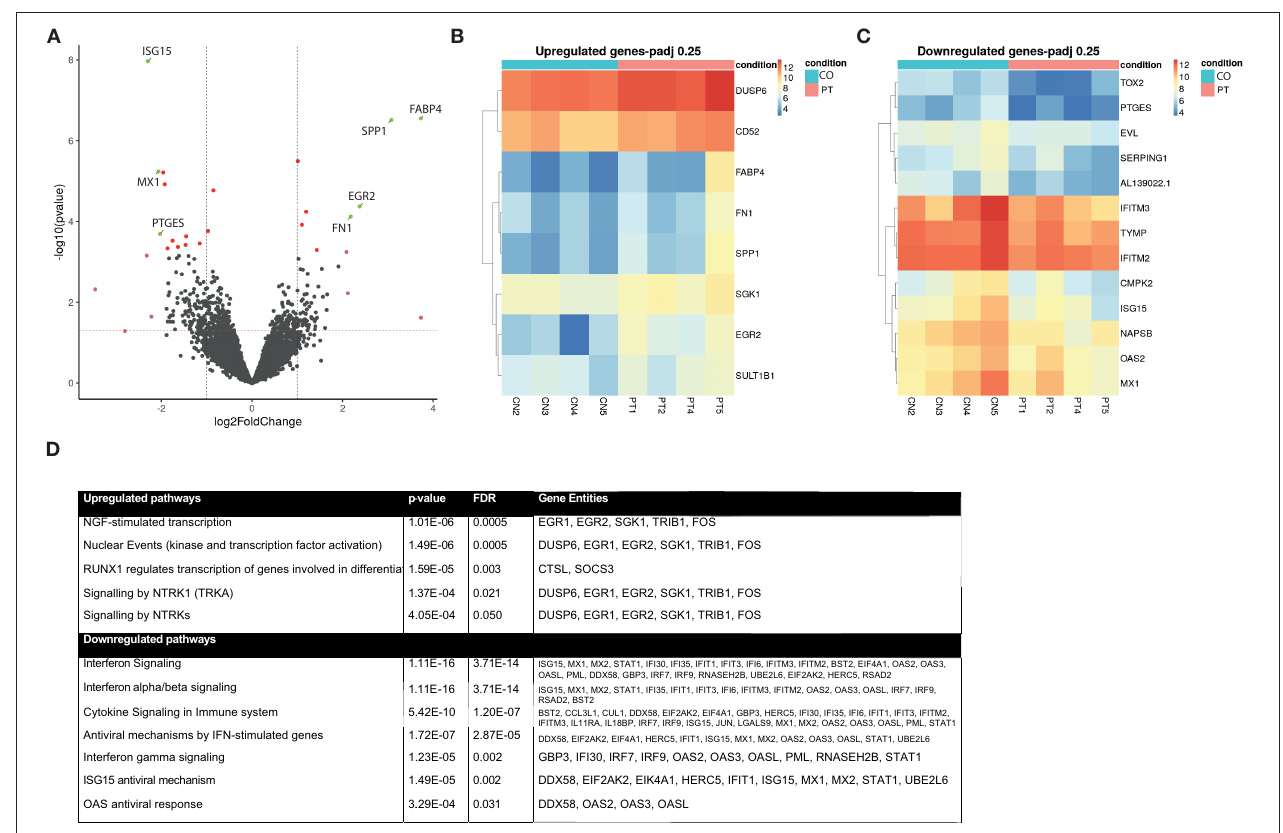
FIGURE 3 | Monocyte transcriptome analysis. Differentially regulated gene expression between participants with SVD progression ( n = 4) and without ( n = 4). (A) Volcano plot of differentially expressed genes after sex stratification. Green dots indicate adjusted P -value < 0.25 and log Fold Change > ± 2; Dark red dots, genes with P -adj < 0.25; light red dots, genes with logFC > ± 2. (B) Heatmap of upregulated genes with P -adj < 0.25 corrected for sex. (C) Heatmap of downregulated genes with P -adj < 0.25 corrected for sex. Color coding is based on gene expression in raw counts, ranging from red (high expression value) to blue (low